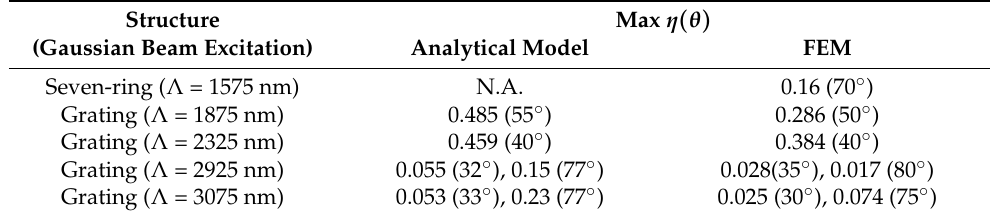
Table 1. Performance comparisons of coupling efficiencies improved by